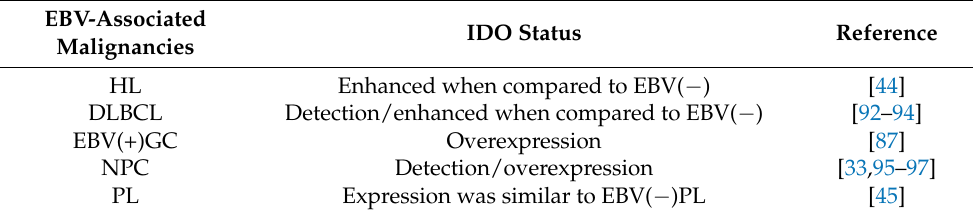
Table 2. IDO expression in EBV-associated